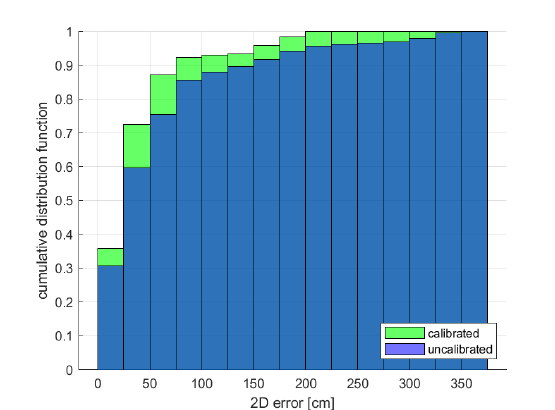
Figure 1. Example of distribution of uncalibrated and calibrated Pozyx UWB